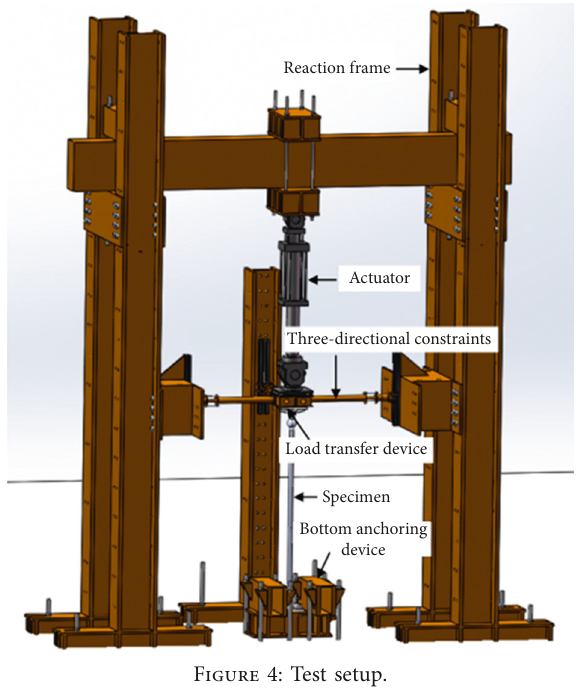
Figure 4: Test setup.